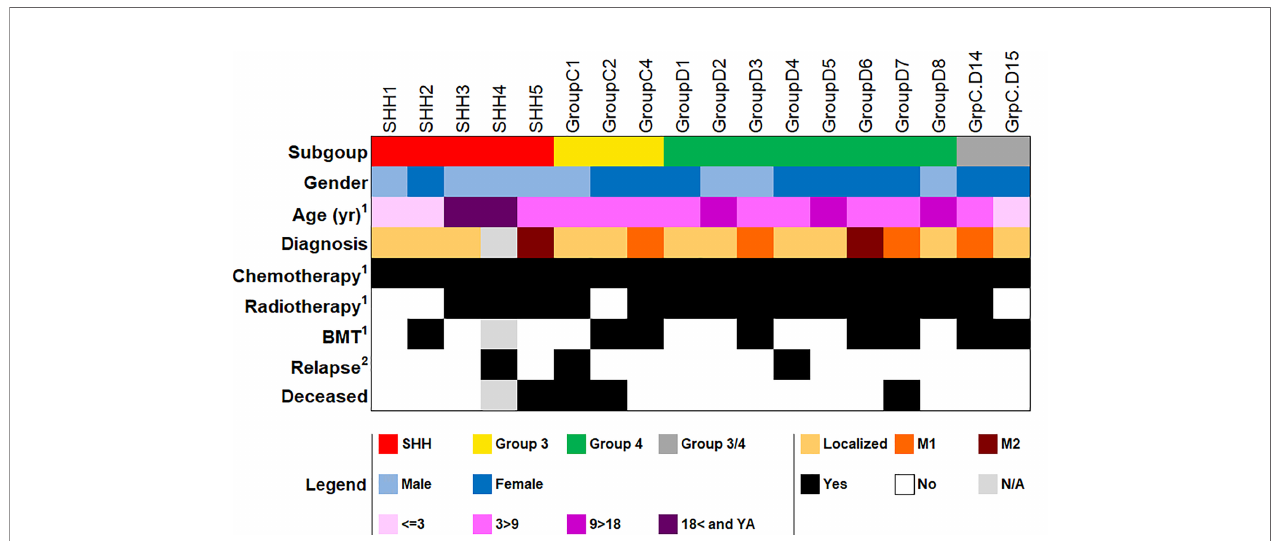
FIGURE 3 | Demographic and clinical data of the patient cohort used for qPCR validation (n = 18). BMT, bone marrow transplantation; YA, young adult; N/A, not available. 1 At fi rst diagnosis. 2 As of the completion of this study. More detailed information in Supplementary Table S6 .